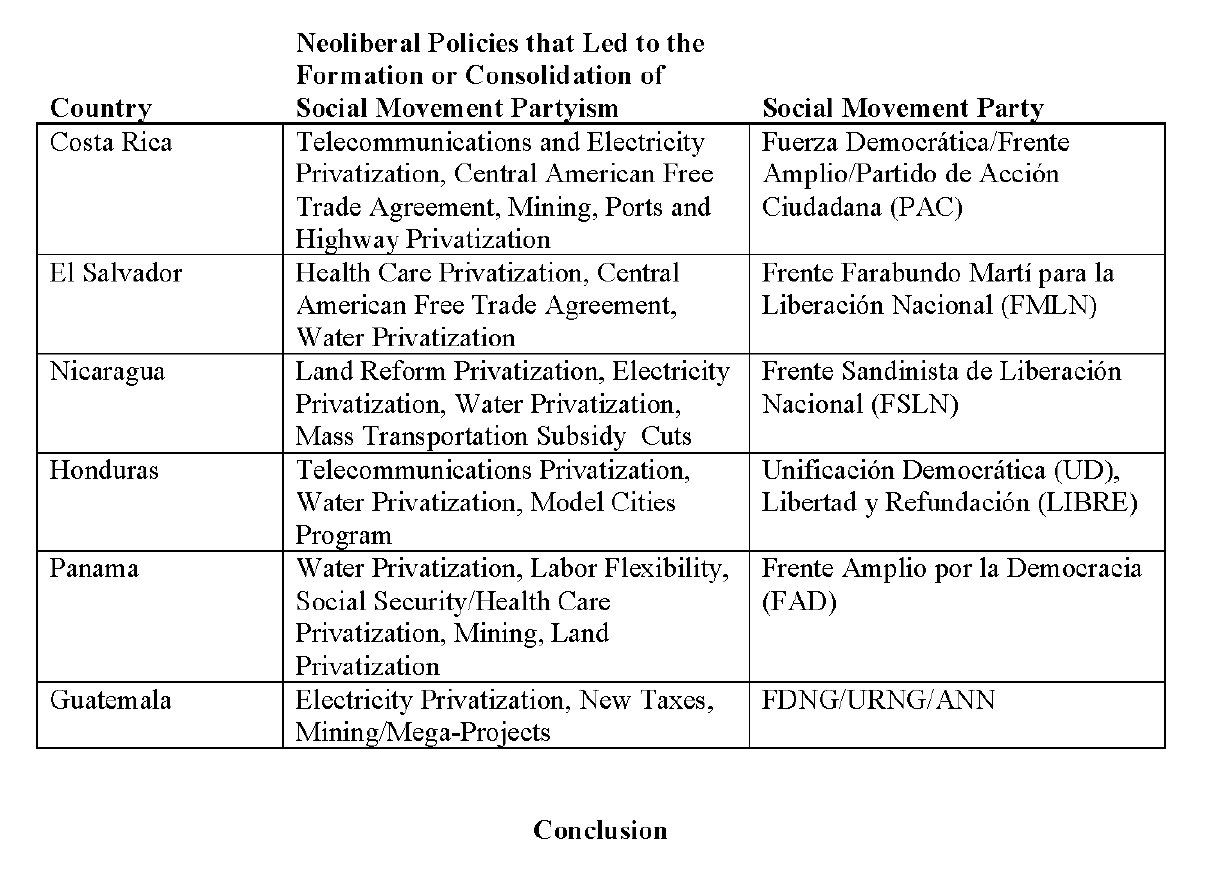
Table 1. Global Neoliberalism and Social Movement Partyism in Central